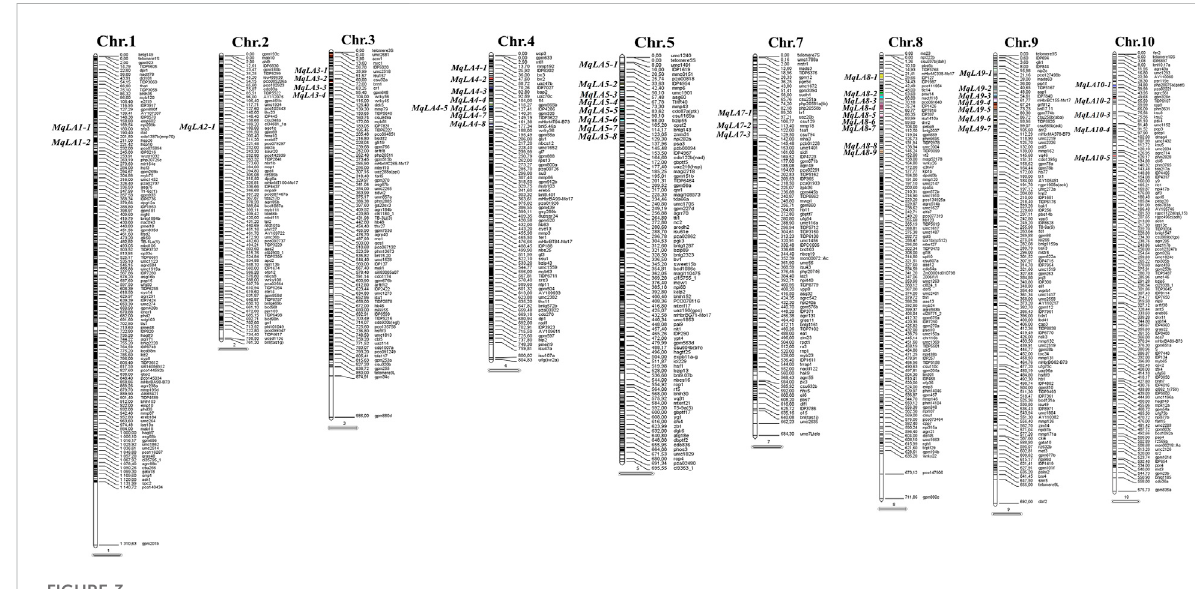
FIGURE 3 Meta-QTLs distributed on maize chromosomes with IBM2 2008 Neighbors as a reference.